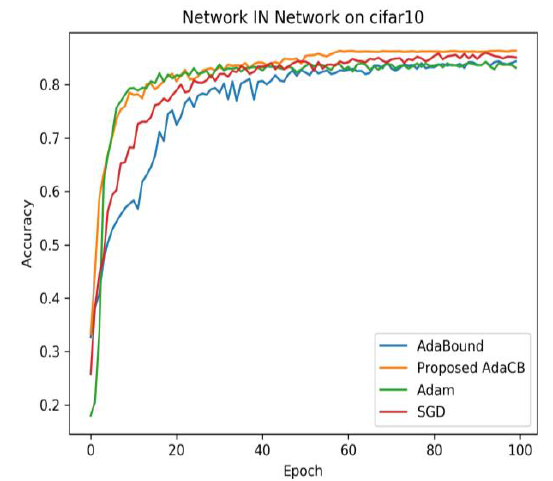
Figure 4. The learning curve of testing accuracy on CIFAR10 under NIN.